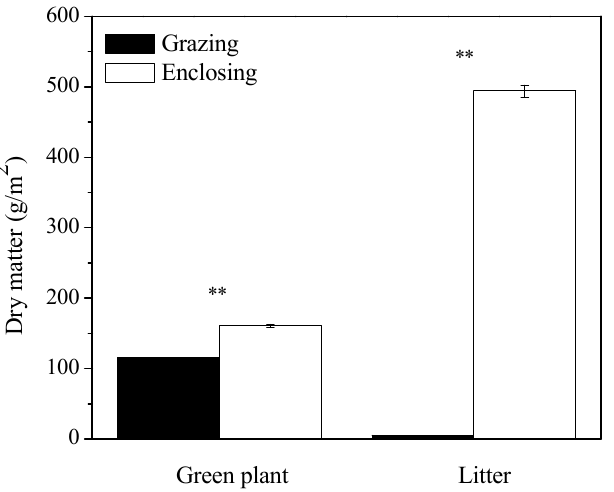
Figure 2. The dry matter of green plants and litter of treatments. Note: ** show significant differences at p < 0.01 of green plant dry matter and litter dry matter between two treatments ( t -test). Error bars are one standard deviation.